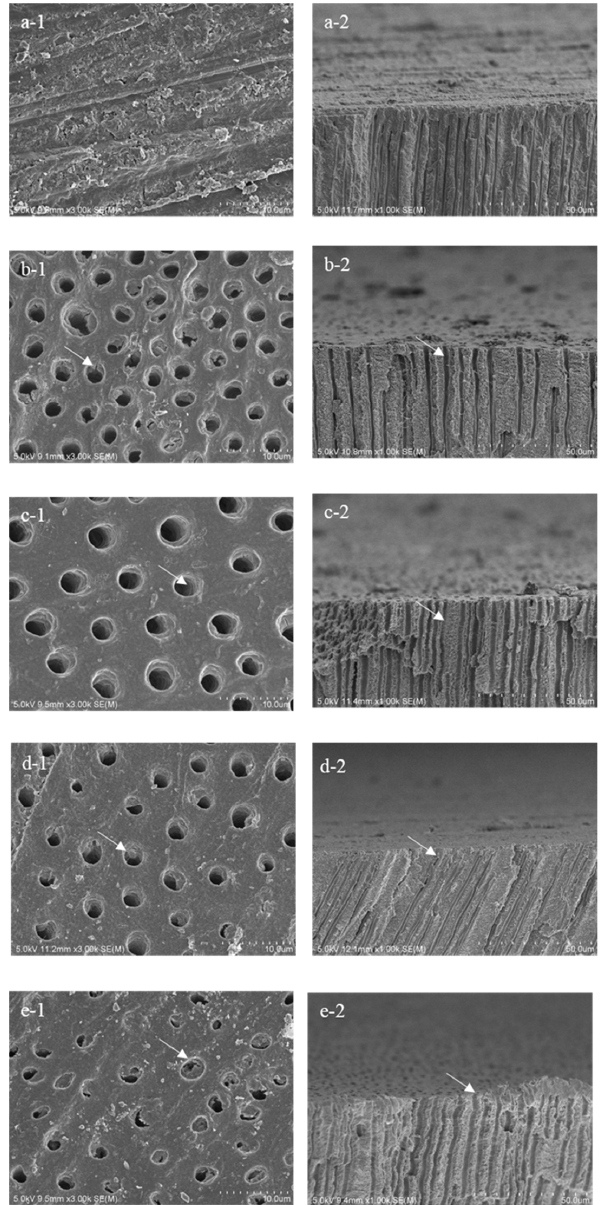
Figure 8. SEM images of the dentin surface (1) and sagittally fractured surface (2) of each group. In the de3 group ( b ), the morphological structure of the peritubular dentin remained (arrow). The peritubular dentin lost its morphological structure in the de6 group ( c , arrow). In the CS group ( d ), remnants were detected within the dentinal tubules (arrow). Reactional deposits were observed on the dentin surface in the NS group ( e , arrow). ( a ) Sound group, ( b ) de3 group, ( c ) de6 group, ( d ) CS group, and ( e ) NS group.